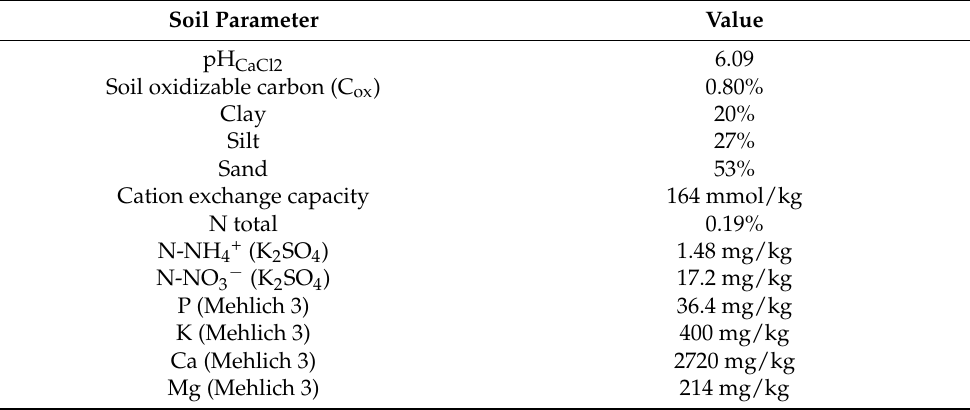
Table 5. Chemical composition of soil used in the lab